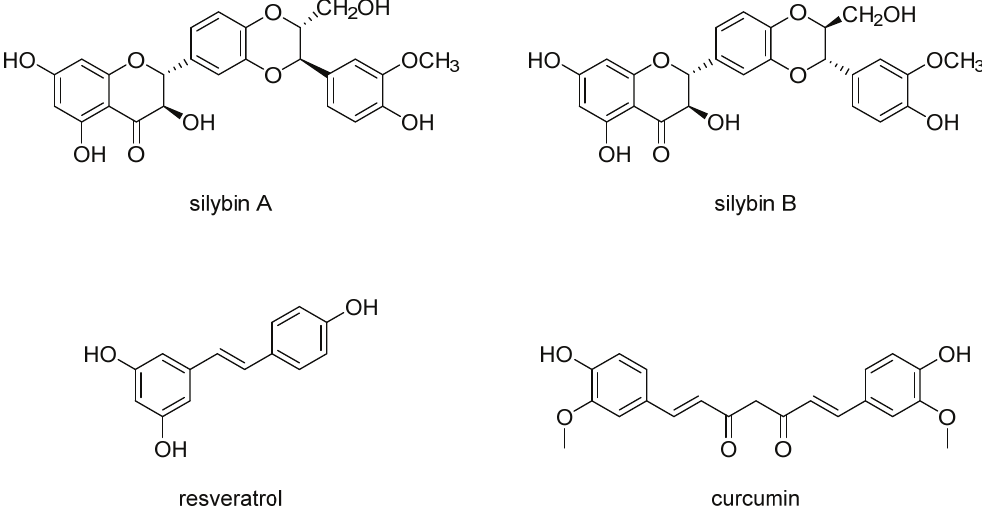
Figure 1. Structures of silybin A and silybin B, resveratrol, and curcumin. Note that silybin A and silybin B comprise the two major flavonolignans in the extract known as silymarin. Silibinin is an equimolar mix of silybin A and silybin B. Not shown are the other 5 flavonolignans that comprise the extract silymarin [44]. The structures share the features of containing multiple phenol groups. Hence, these compounds are all polyphenol-containing natural products.